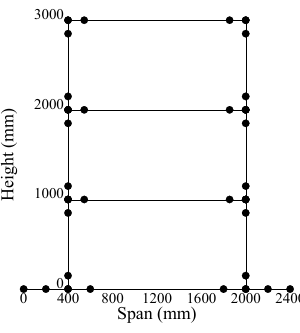
Figure 6. Modelling of the CFST (concrete filled steel tubular) frame specimen.